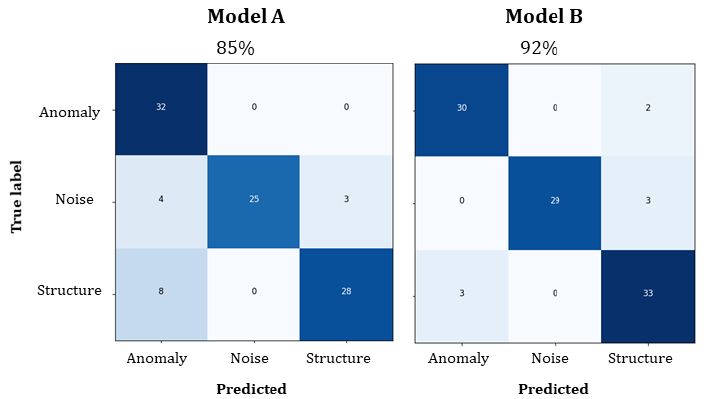
Figure 4. Confusion matrices calculated on the evaluation set for Model A and Model B, reaching the classification accuracies of 85% and 92%, respectively. As for the noise class, Model A made seven mistakes, while Model B made three.